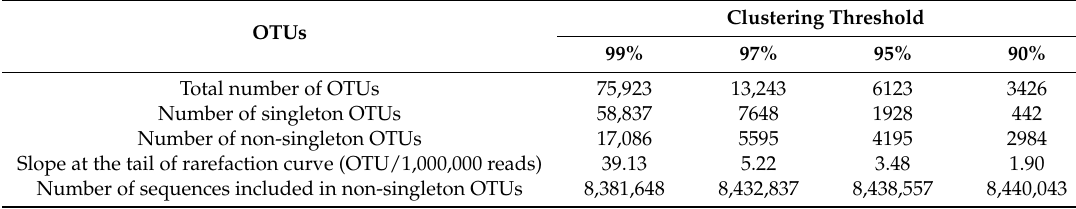
Table 2. Number of operational taxonomic units (OTUs) at each clustering threshold. OTUs